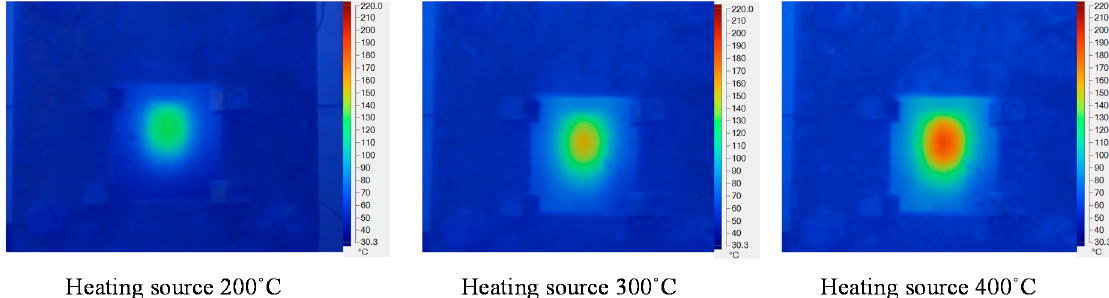
Polymers 2021 , 13 , 1004